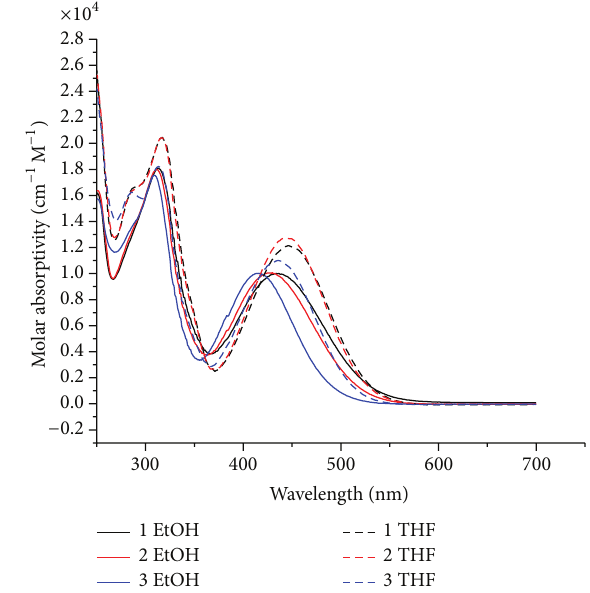
Figure 1: Absorption spectra of 5 × 10 −5 M solutions of PT1–3 dyes in EtOH and THF,